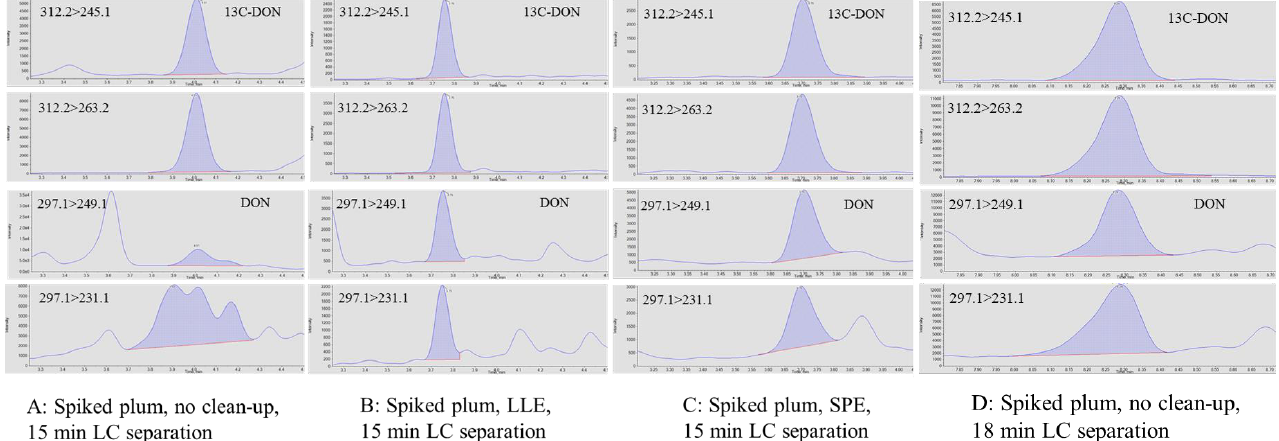
Figure 2. Detection of 13C-DON and DON spiked in plum using different clean-up and LC separation conditions. ( A ): without additional clean-up, no detection of DON with the 15 min LC method. ( B ): sample prepared using LLE, DON detected; no modification of the 15 min LC method. ( C ): sample prepared using LLE, DON detected; no modification of the 15 min LC method. ( D ): without any clean-up, DON detected with an 18 min LC method.